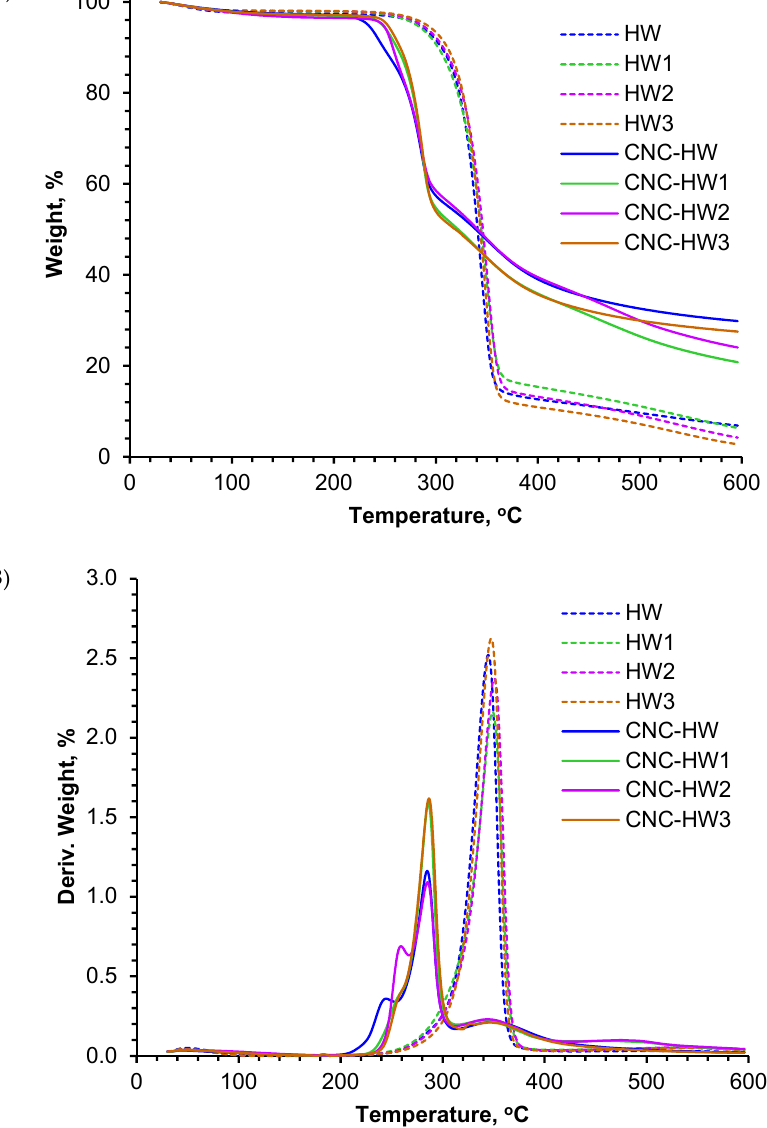
Figure 5. TGA ( A ) and DTG ( B ) curves of HW Control and oxidized HW and their corresponding CNC. Generally, the DTG curves for CNC materials show one (one T max ) only in the 250 and 325 ◦ C temperature range. This range may be affected by the hydrolysis reaction conditions and the pulp quality. This is the case for CNC-HW1 and CNC-HW3 in Figure 6, where the T max positions were around 286 ◦ C and in the 220 and 315 ◦ C temperature range. CNC-HW2 and CNC-HW Control samples also displayed T max positions at about 286 ◦